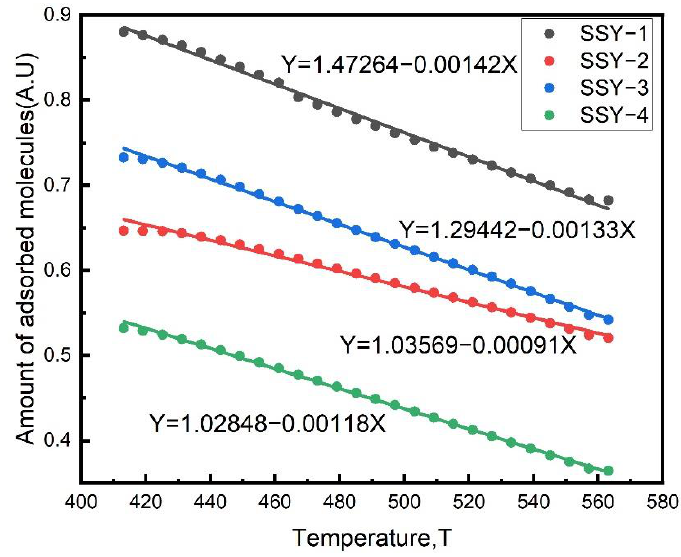
Figure 6. The ammonium hexafluorosilicate modified zeolites linearly fitting curve of pyridine coverage in Brønsted.